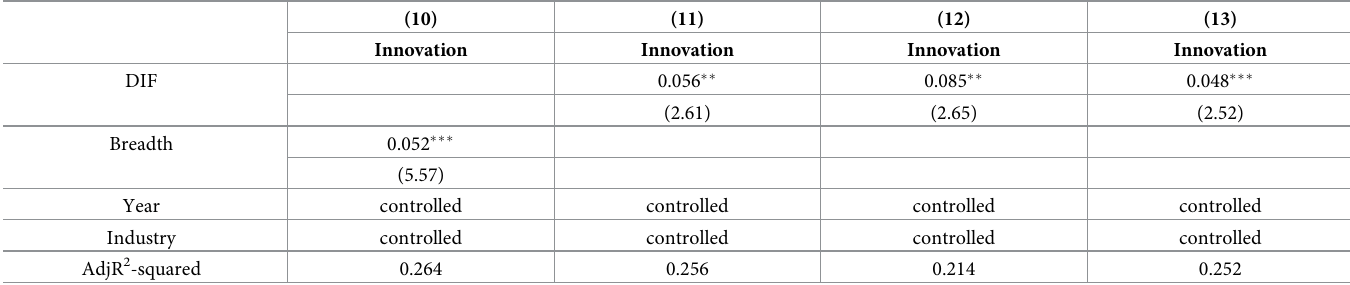
Table 5. The regression results of the endogeneity